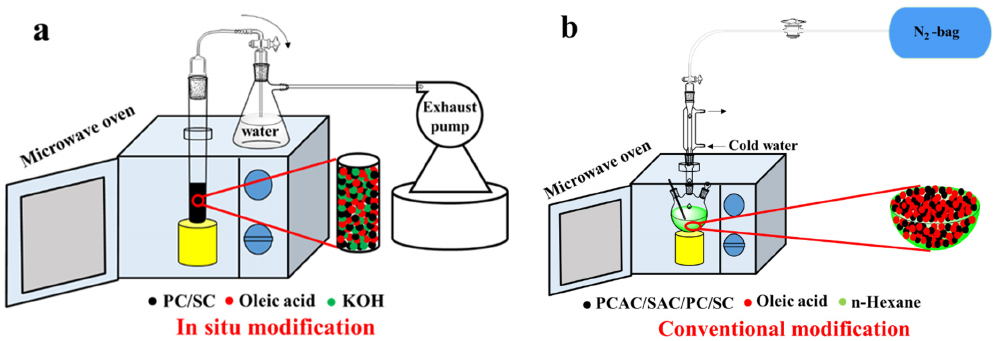
Figure 1. A schematic diagram illustration of the in situ and conventional modification with oleic acid (OA) using microwave heating.